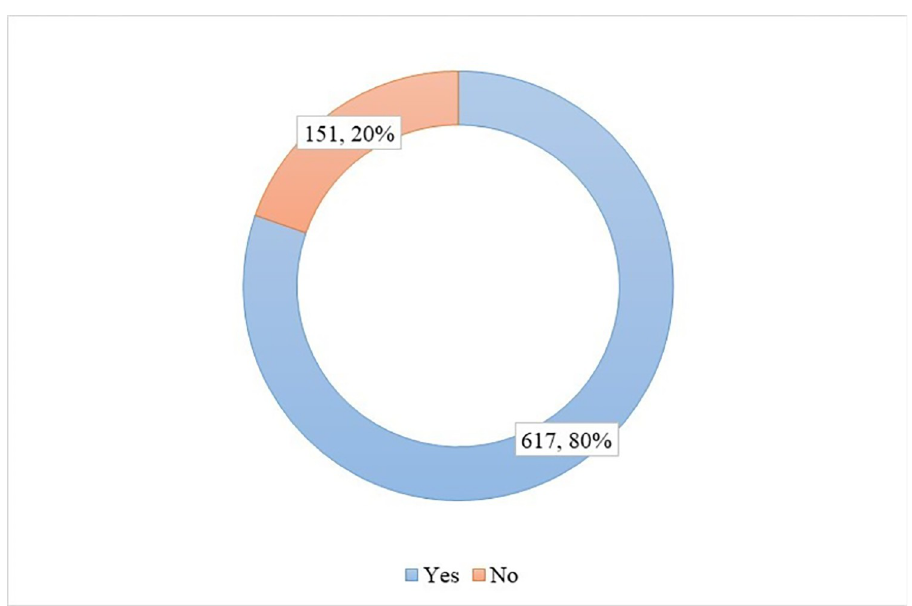
Fig 3. The prevalence of facemask usage among the